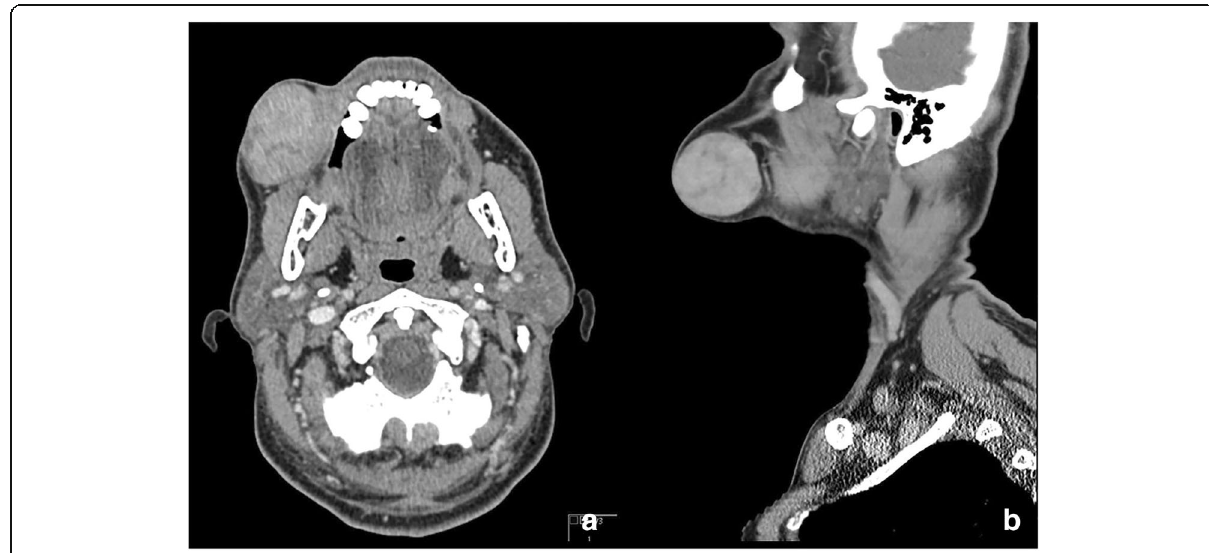
Fig. 8 SFT of the buccal space. Axial ( a ) and sagittal ( b ) CT images showing a spherical enhancing mass in the right buccal space, biopsy proven to be a